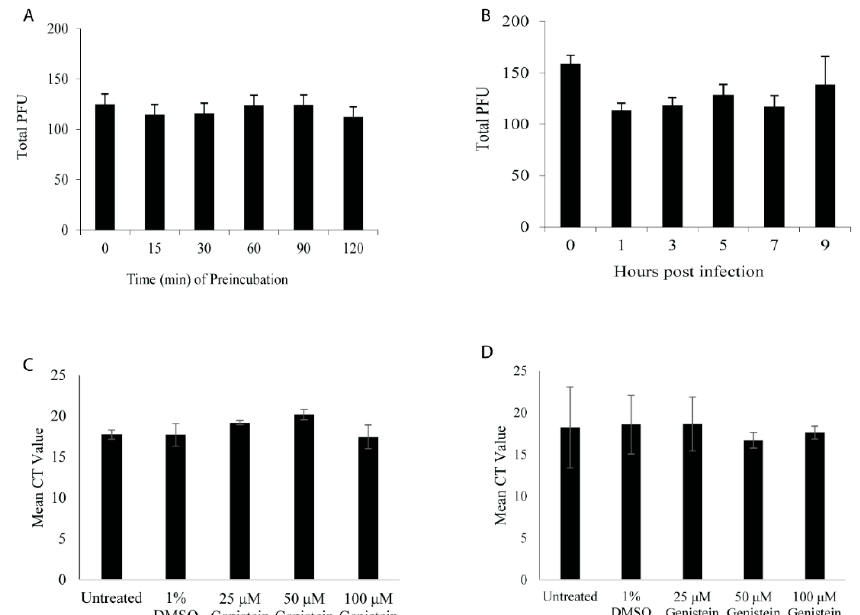
Figure 3. Genistein does not directly inactivate B virus; instead, it inhibits the virus after virus replication. ( A ) Direct inactivation assay. Veros were infected with 150 PFU of B virus following pre-incubation of B virus with 50 µ M genistein for 0–120 min. A standard plaque assay was performed and the total PFU counted. ( B ) Plaque reduction assay. Veros were infected with 150 PFU of B virus and 50 µ M of genistein was added at various times post-infection. A standard plaque assay was performed and the total PFU counted. RT-PCR results for total genomic virus post-48 h infection of HFFs ( C ) or RMFs ( D ) following B virus infection in the presence of increasing concentrations of genistein or 1% DMSO (control).